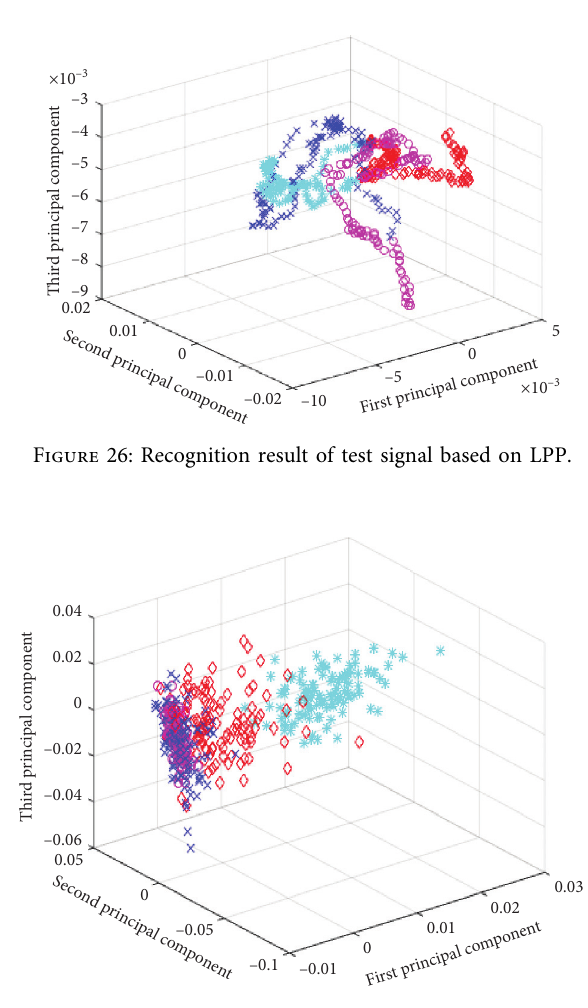
Figure 25: Recognition result of test signal based on LLE.